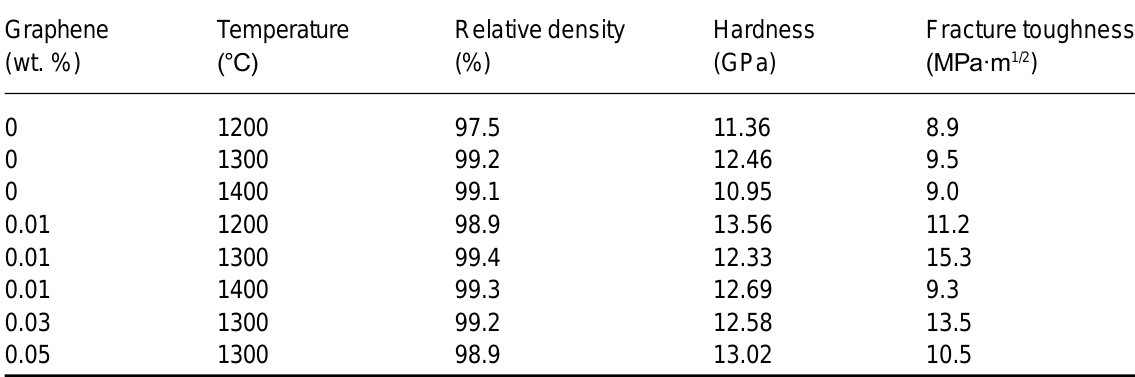
Table 2 . Mechanical properties and the relative densities of zirconia-graphene composites obtained by PAS approach, data from